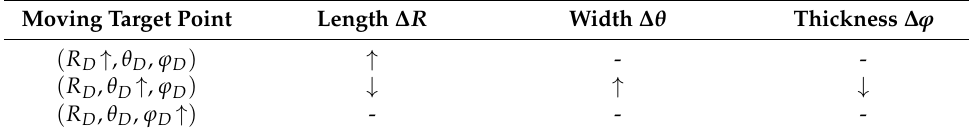
Table 1. Relationship Between the Beam Pattern and Target Point